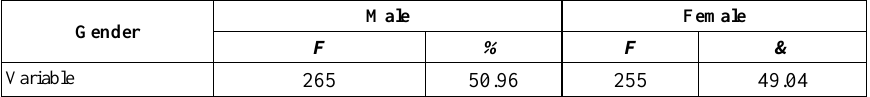
Table 1. Distribution of university students by gender